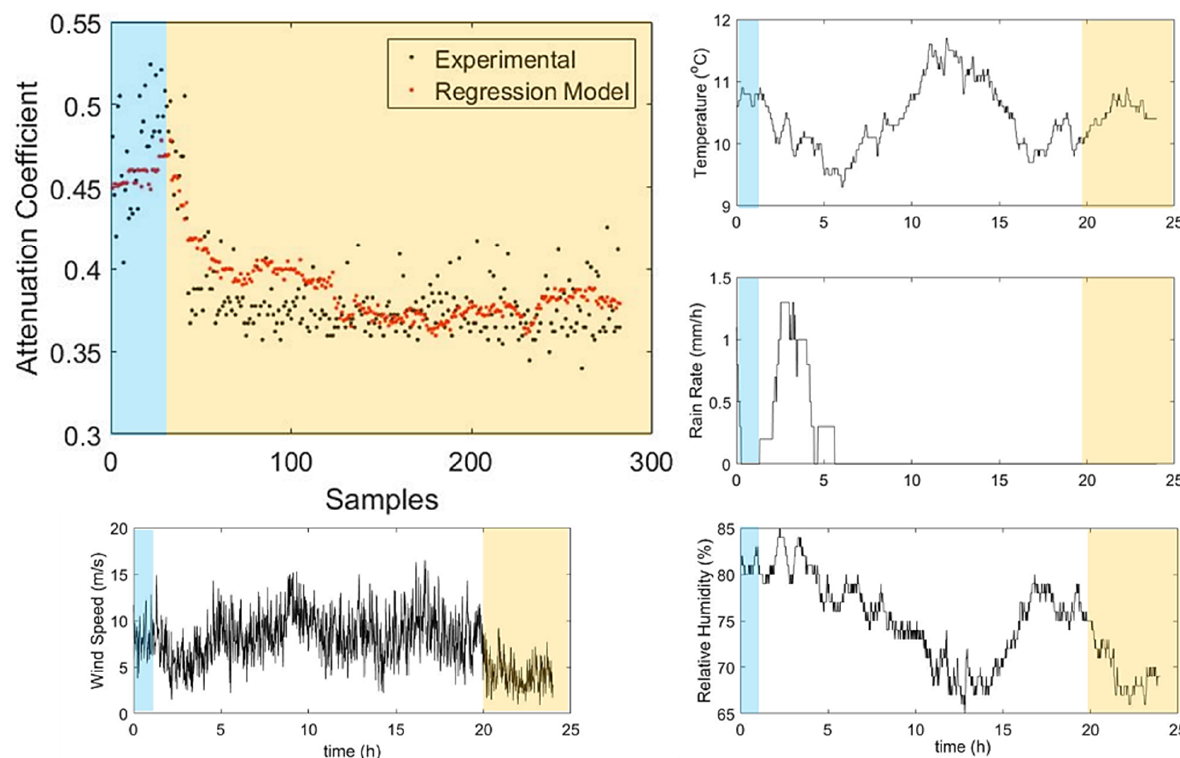
Figure 9. Experimental measurements and model predictions, i.e., Equation (6), for 6 April 2020.